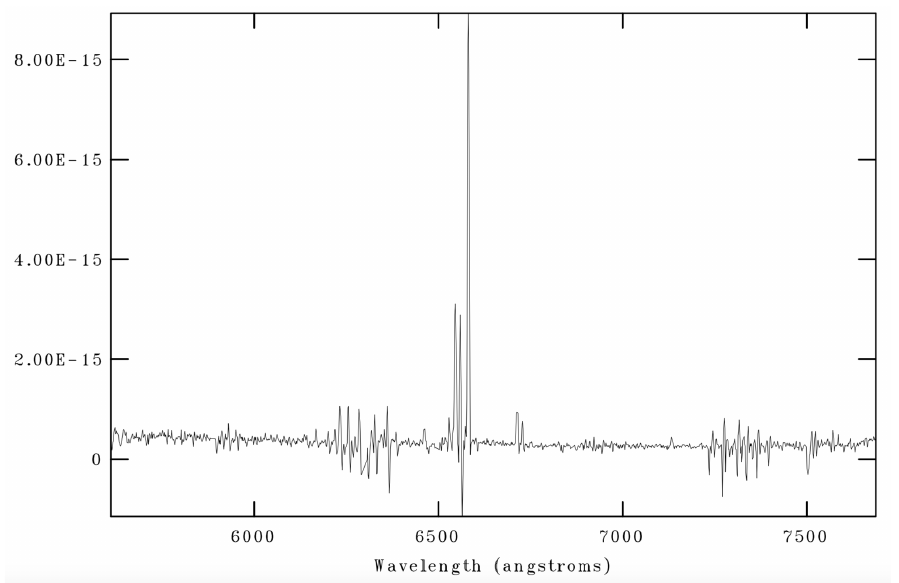
Figure 4. Our new FORS2 2019 nebular red spectrum. There were problems with sky subtraction due to the extent of the large angular size PN across the slit that have left many residuals. The H α line is a little oversubtracted. Nevertheless, the strong [NII] 4648, 4684 Å emission lines indicate the nebular Type I nature also evident from the earlier SPIRAL data.